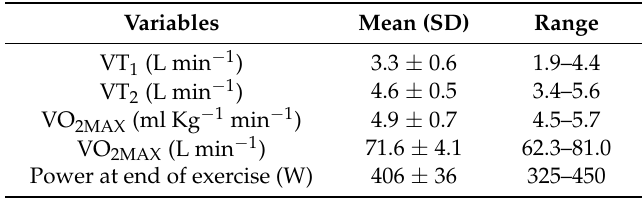
Table 1. Physiological (mean ± SD) characteristics of the participants (N = 16) calculated from the incremental test.